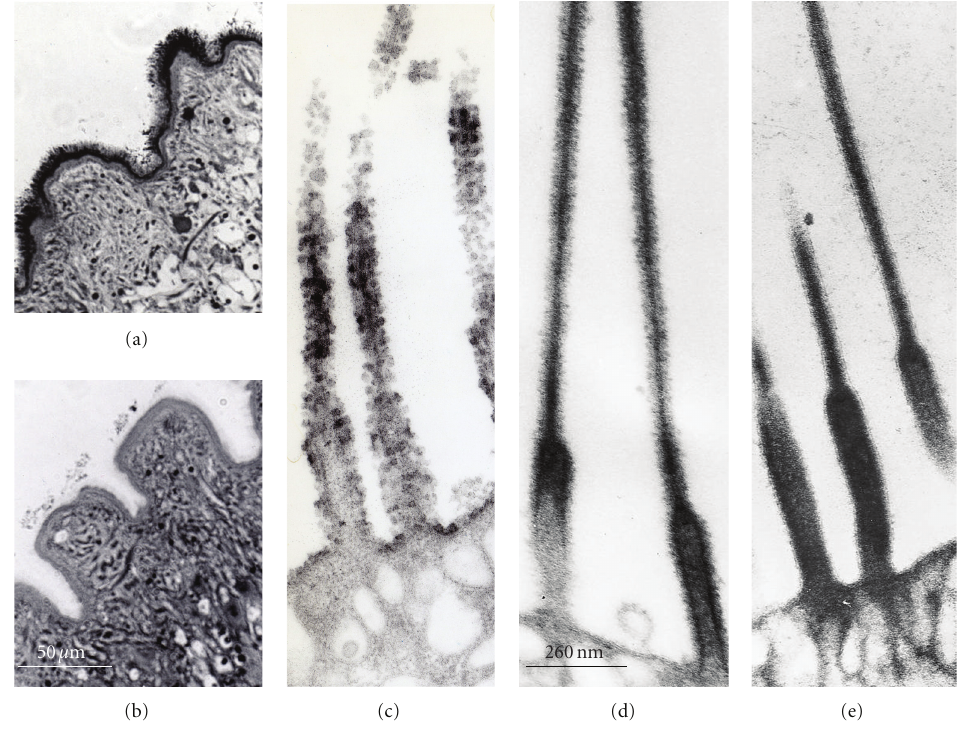
Figure 2: Micrographs of the tegumentary surface of Taenia solium cysticerci: light and electron micrographs of sections of the bladder wall of cysticerci incubated for 1 hour with PBS ((a) and (c)) and PLC ((b) and (d)) probed with anti-GP1. (e) IgG from preimmune serum rabbit was used as control. HRP-conjugated goat anti-rabbit IgG was used as secondary